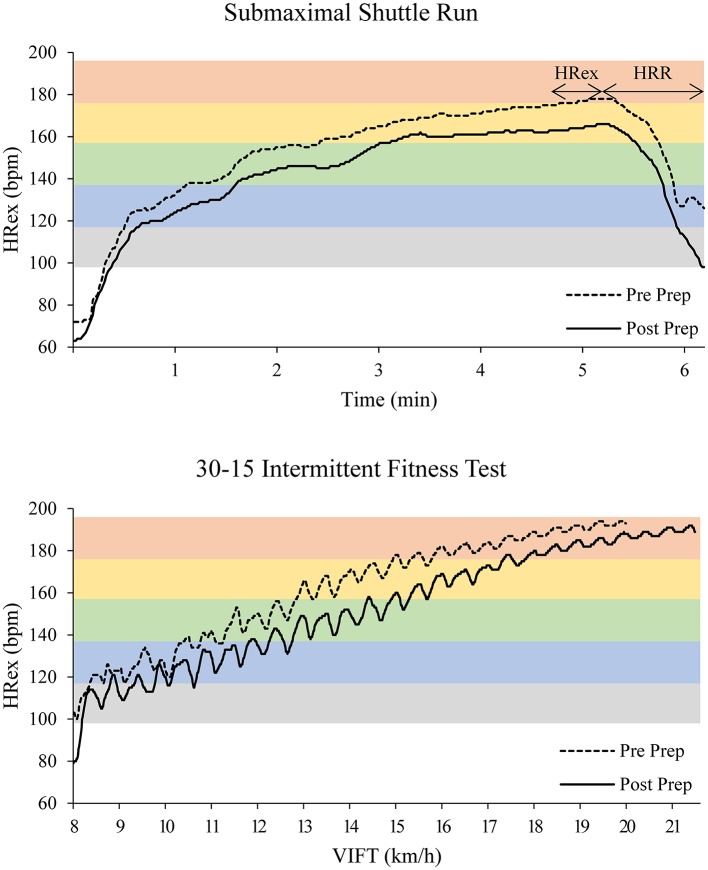
Example of heart rate (HR) recordings during submaximal and maximal shuttle runs as part of preseason performance testing in a semi-professional basketball player. Performance testing was conducted at the beginning and the end of an 8-week preseason preparation period for a 25-year-old semi-professional basketball player. The submaximal shuttle run consisted of 5 min of running (~1, 1, and 3 min at 9.0, 10.5, and 12.0 km/h, respectively; 28 m shuttle length) followed by 1 min of passive recovery and was performed as the first part of the warm-up. Maximum (aerobic) fitness was assessed using an incremental field test (30-15 IFT, 30-15 Intermittent Fitness Test, Buchheit, 2008) at the end of each session. The player showed a 1.5 km/h increase in maximum running speed (VIFT), a 13 bpm decrease in exercise HR during, and a 16 bpm increase in HRR following, the submaximal shuttle run. The colored horizontal bars represent 10%-wide HR zones starting at 50%HRmax (e.g., red bar: 90–100%HRmax). HRex: exercise HR; HRR: HR recovery over 60 s; Prep: preparation period.